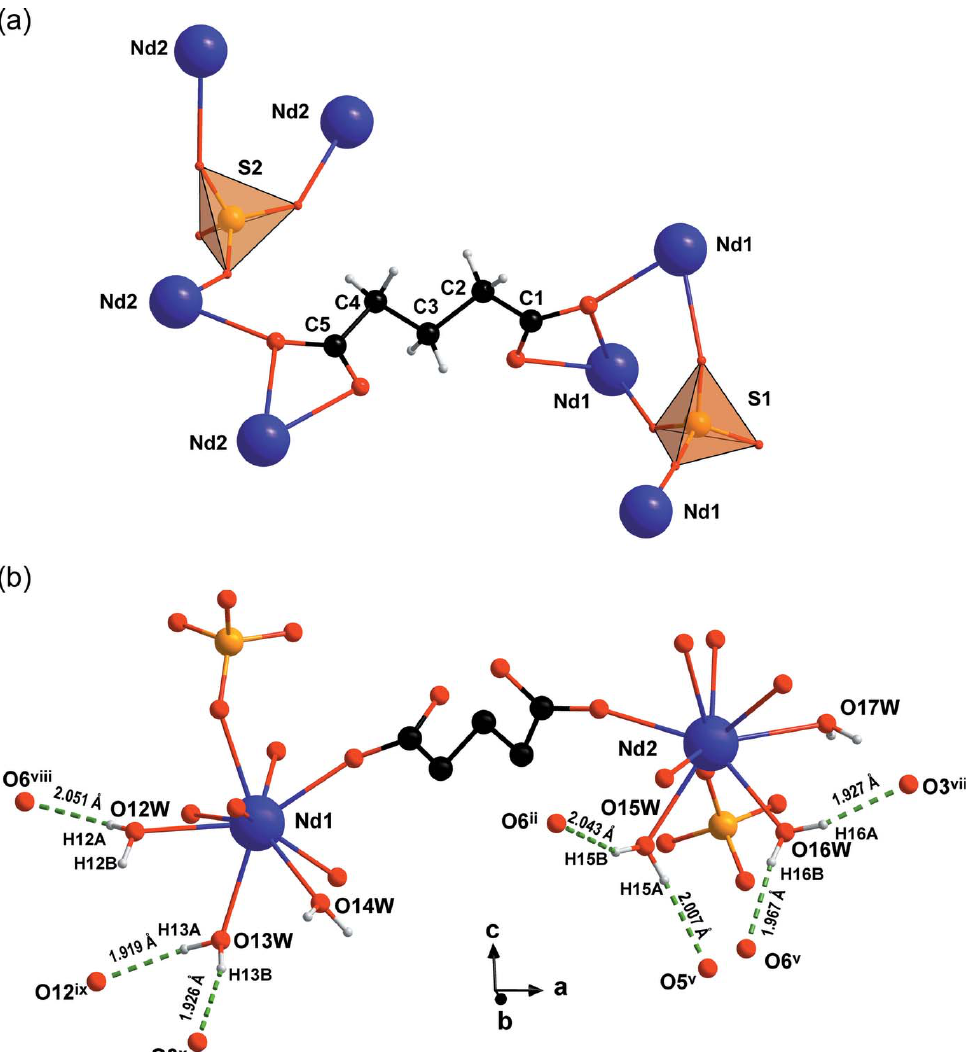
Figure 2 Depictions of ( a ) the coordination modes of the glutarate and the sulfate ligands in 1 and ( b ) seven of the eleven crystallographically independent hydrogen bonds (dashed green lines) with bond distances. [Symmetry codes: (i) (cid:3) x + 2, (cid:3) y , (cid:3) z ; (ii) (cid:3) x + 2, y (cid:3) 1 (cid:3) y + 1, (cid:3) z ; (v) x , (cid:3) y +